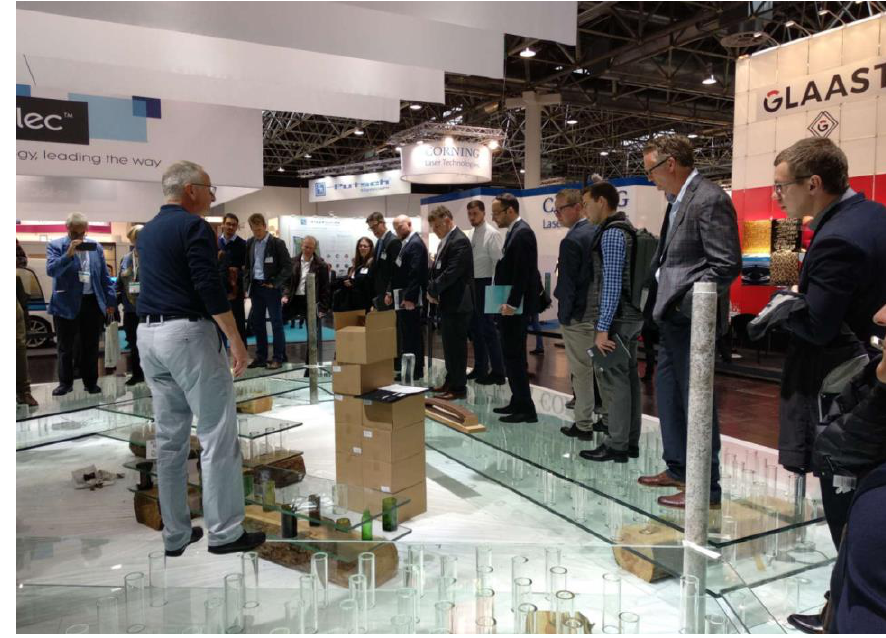
Fig. 16 Panel loaded with visitors at glasstec